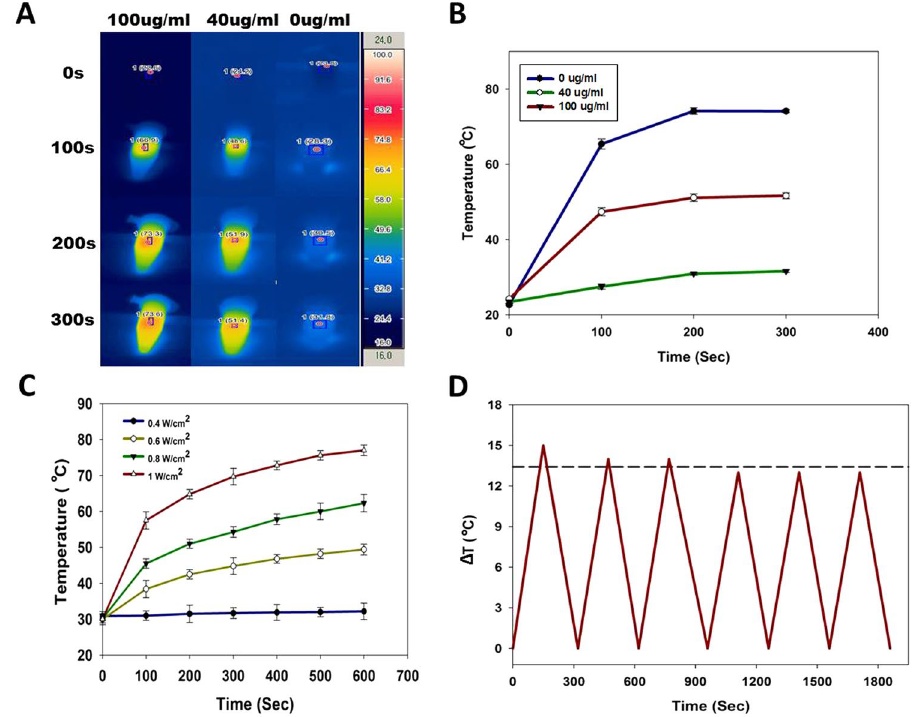
Figure 9. Photothermal studies of MHI-DSPE-SPION. ( A ) Infrared thermo-graphic images of 100 µ g/mL, 40 µ g/mL and 0 µ g/mL MHI-DSPE-SPION after irradiation for 300 sec at 1 W/cm 2 density. ( B ) Temperature rise after 300 sec of laser irradiation for different concentrations of MHI-DSPE-SPION. ( C ) Temperature rise after 600 sec of laser irradiation for MHI-DSPE-SPION solutions (20 μ g/mL) of different laser powers. ( D ) Photothermal stability study of MHI-DSPE-SPION